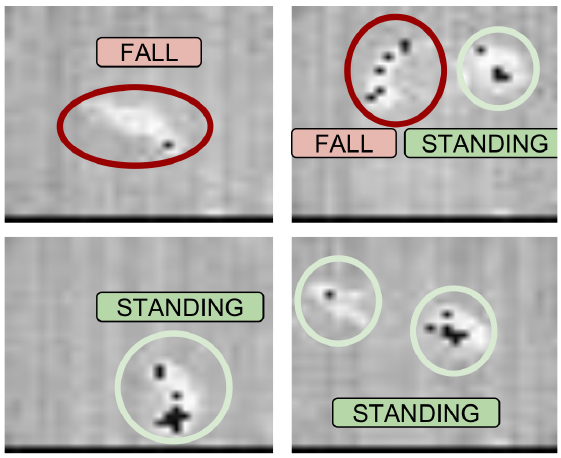
Figure 4. Example of problematic images to detect falls from thermal vision sensor. In Top, two falls are presented. Bottom, standing/walking people is